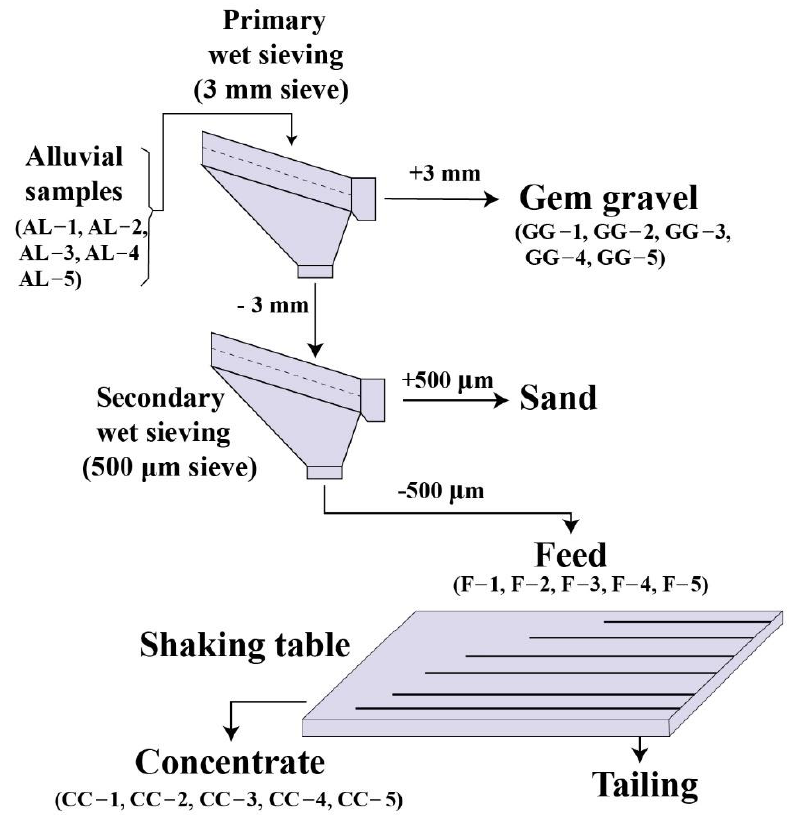
Figure 3. Physical separation flowsheet of gem-bearing alluvial samples.